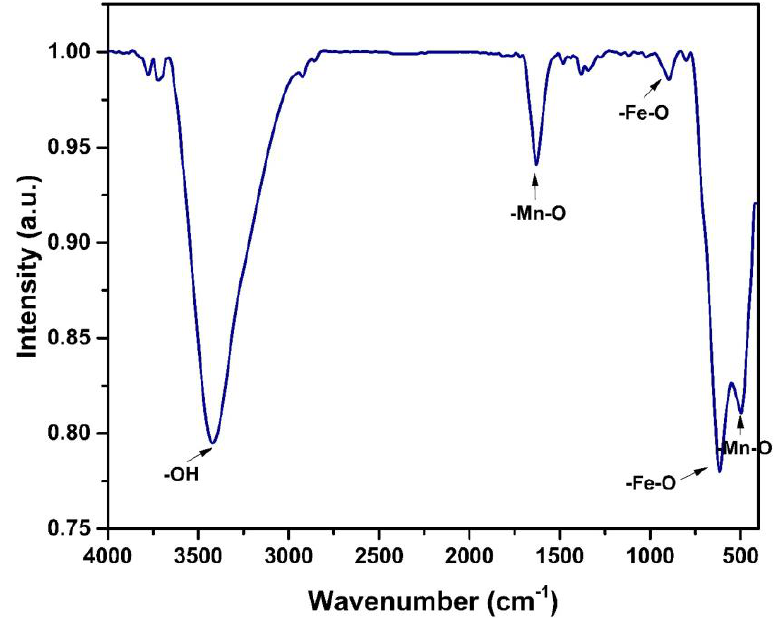
Figure 2. FTIR spectra of FeMn bimetallic catalyst.